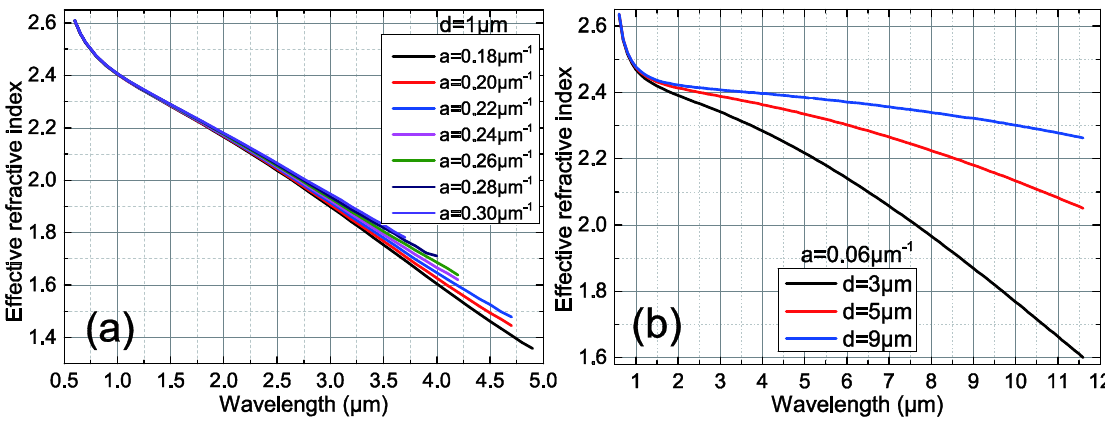
Figure 6. Impact of parameters ( a ) a , ( b ) d on n eff of FM.